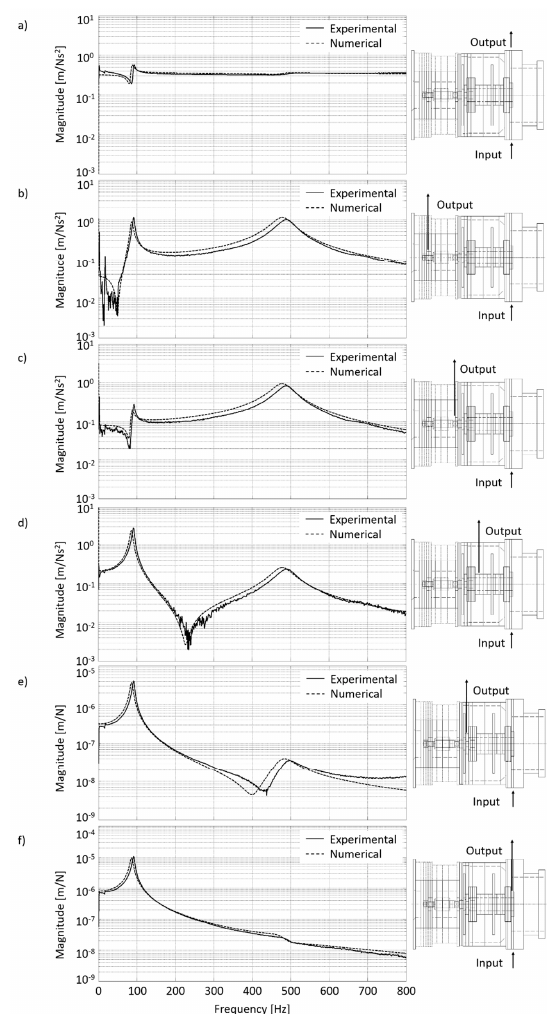
Figure 11. Characterization in static conditions of the assembled pump by impact test. The input force is on the stator while the measured outputs are: ( a ) Acceleration of the stator. ( b ) Acceleration of the rotor in correspondence of the SES damper location. ( c ) Acceleration of the rotor in correspondence of the CS damper location. ( d ) Acceleration of the rotor on the mock-up impeller. ( e ) Relative displacement between rotor and stator in the lower part of the impeller mock-up. ( f ) Relative displacement between rotor and stator in the higher part of the impeller mock-up.